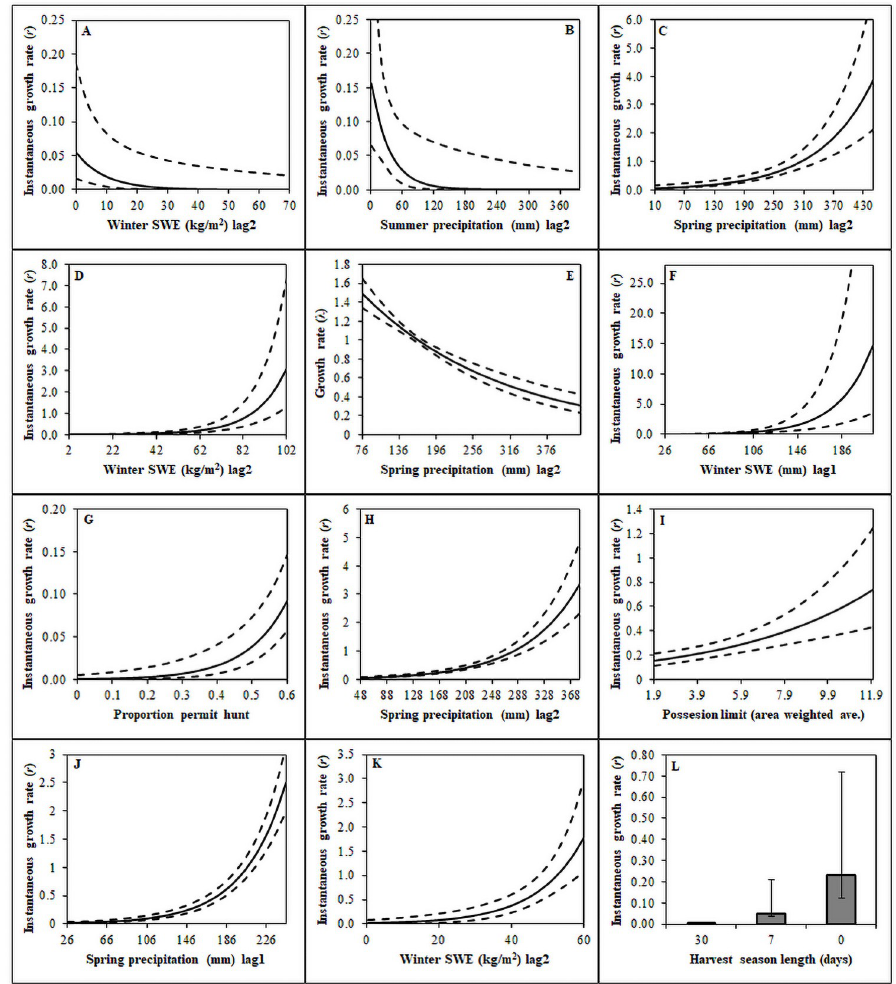
Fig 4. Predicted effects of weather and harvest exposure variables on the instantaneous growth rate ( r ) or maximum per capita rate of increase (lambda [ λ ]) from open population N-mixture models. Variables are labeled on the x-axis and refer to the following regulation histories: Never 1995 (A) and (B), Never 1996 (C), First-Year (D), Jackson (E), Permit (F) and (G), Upland (H) and (I), Study-Continuous (J), and Study-Discontinuous (K) and (L). Male count data were collected by states and provinces throughout the western United States and southern Alberta and Saskatchewan Canada from